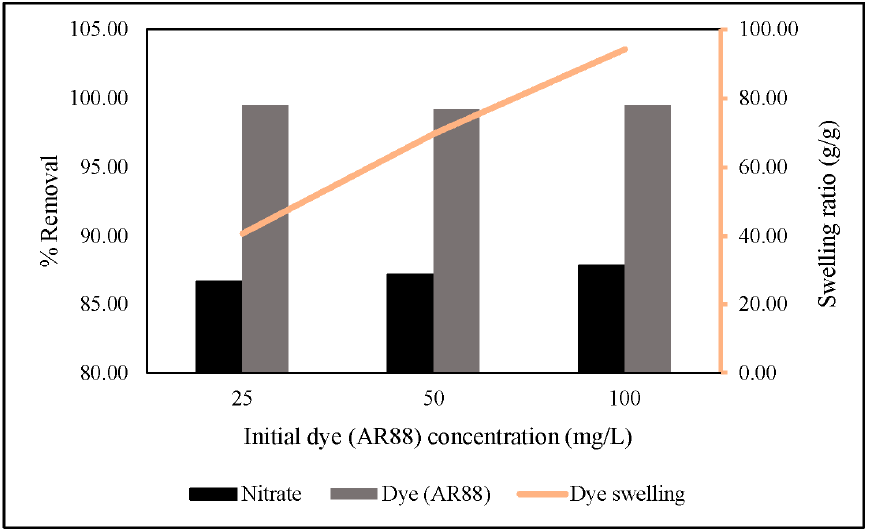
Figure 12. Effect of different initial dye (AR88) concentrations on nitrate and dye removal (10 mg of ZLCH-Fe; initial NO 3 : 100 mg/L; initial dye (AR88): 25, 50 and 100 mg/L; contact time: 5 min).